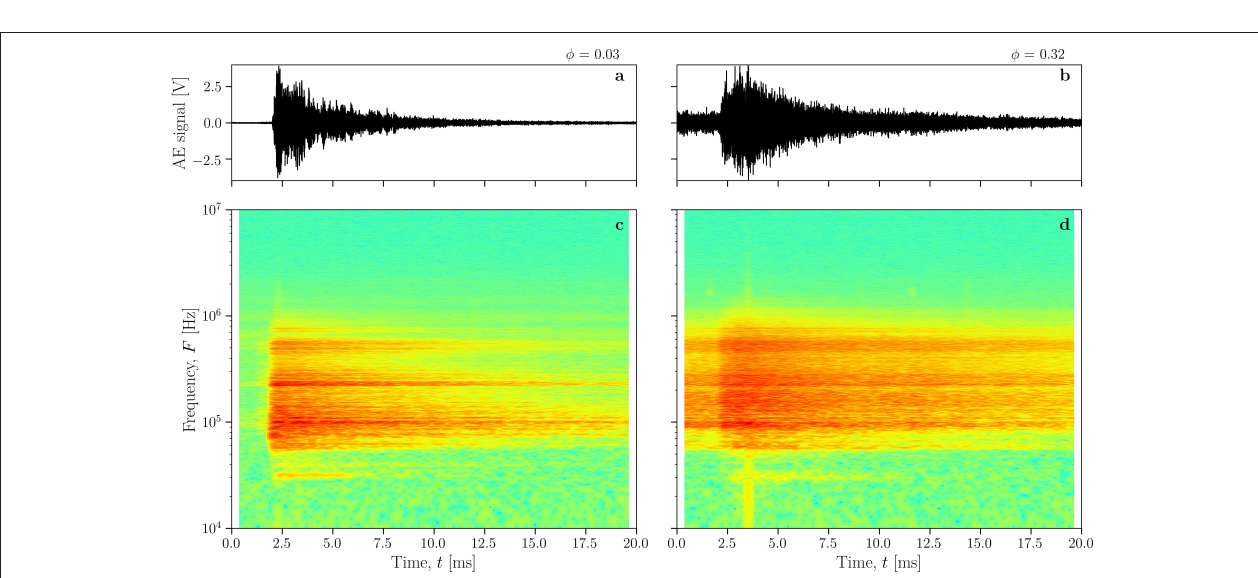
FIGURE 6 | Typical waveforms for low porosity (a) and high porosity (b) samples with their related spectrograms (c,d) , showing that the peak amplitude and frequency range does not significantly